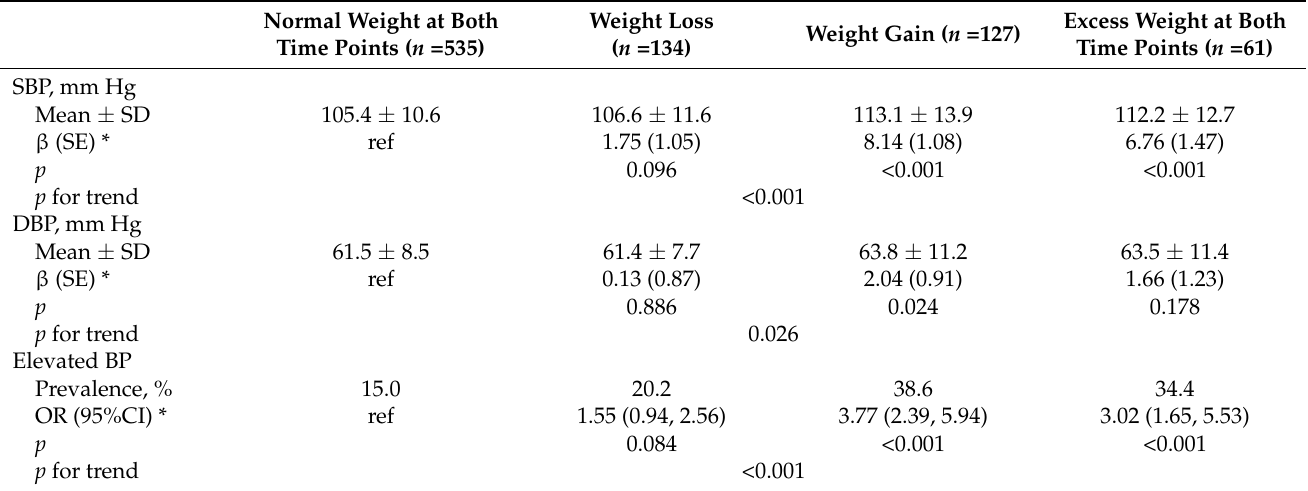
Table 4. Association of weight change from birth to adolescence with elevated BP in